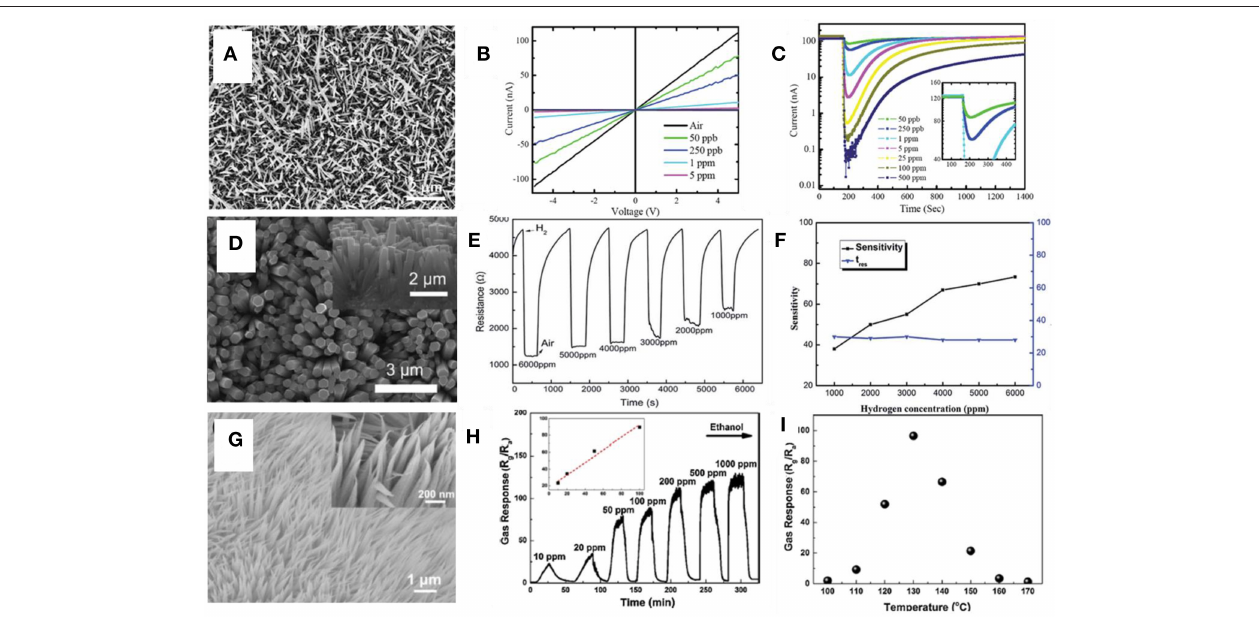
FIGURE 7 | (A) Top view SEM images of a WO 3 -nanowire array. (B) IV curves of gas response to NO 2 with different concentrations. (C) Dynamic resistance-metric response curves to NO 2 . Reprinted with permission from Cao et al. (2009), copyright The Royal Society of Chemistry 2009. (D) SEM images of Nb 2 O 5 nanoarrays. (E) dynamic response to the different concentrations of H 2 ; (F) The relationship of sensitivity and response time vs. H 2 concentration; Reprinted with permission from Zou et al. (2018), copyright The Royal Society of Chemistry 2018. (G) Top view SEM images of Co 3 O 4 nanoneedle arrays. (H) The dynamic response curve of the Co 3 O 4 nanoneedle arrays to ethanol. The linear dependence of the gas response in the low concentration ethanol is attached in the inset figure. (I) The Temperature dependent gas response to ethanol. Reprinted with permission from Wen Z. et al. (2014), copyright 2014 Elsevier